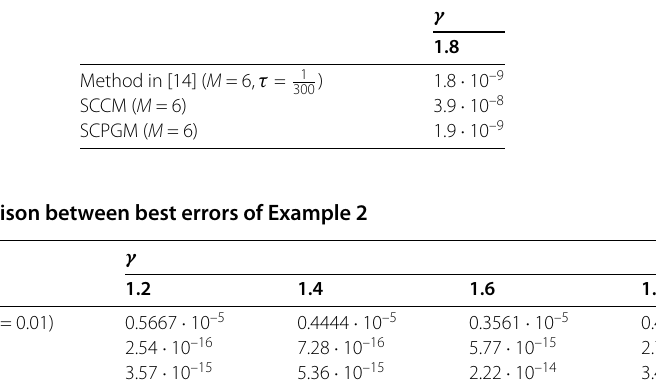
Table 2 Comparison of best errors of Example 1